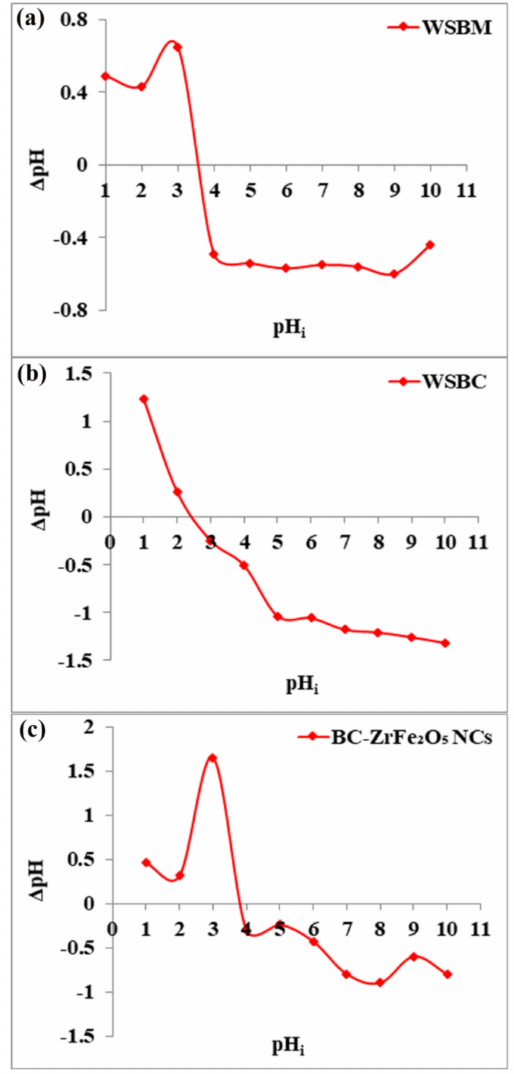
Figure 2. pH pzc of adsorbents: ( a ) wheat straw biomass (WSBM), ( b ) wheat straw biochar (WSBC) and ( c ) biochar-based zirconium ferrite nanocomposite (BC-ZrFe 2 O 5